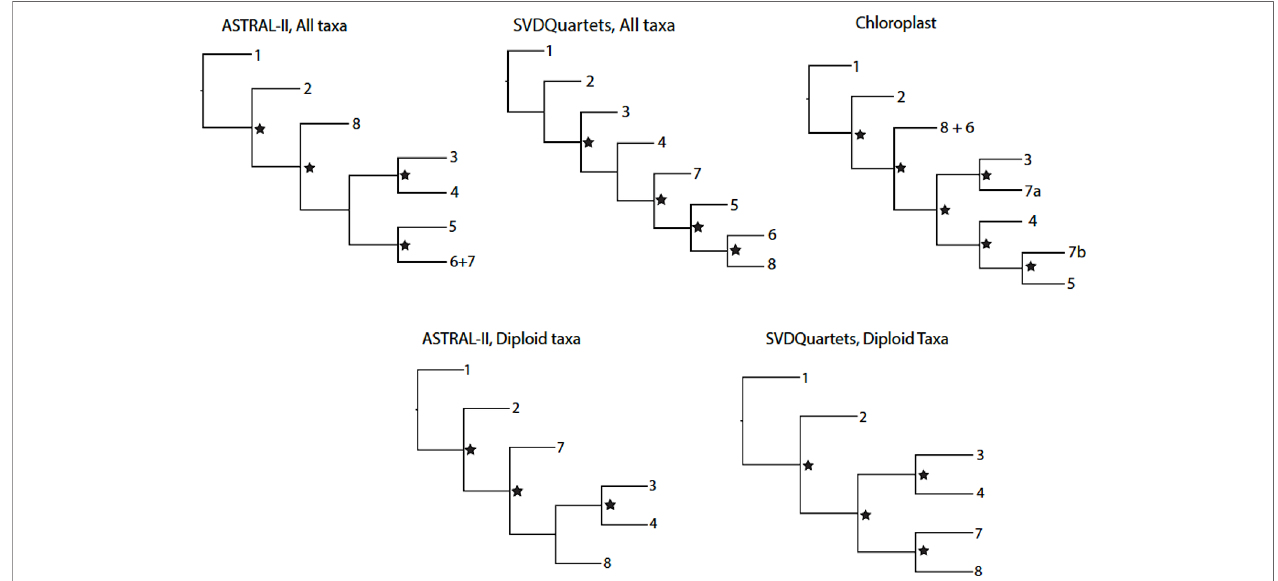
FIGURE 1 | Topological relationships between genus Rubus Groups 1 – 8 in phylogenetic analyses of exon or chloroplast sequences. Nodes with strong support (Bootstrap > 75 for SVDQuartets phylogenies; Posterior Probability > 0.95 for ASTRAL-II phylogenies) are marked with a